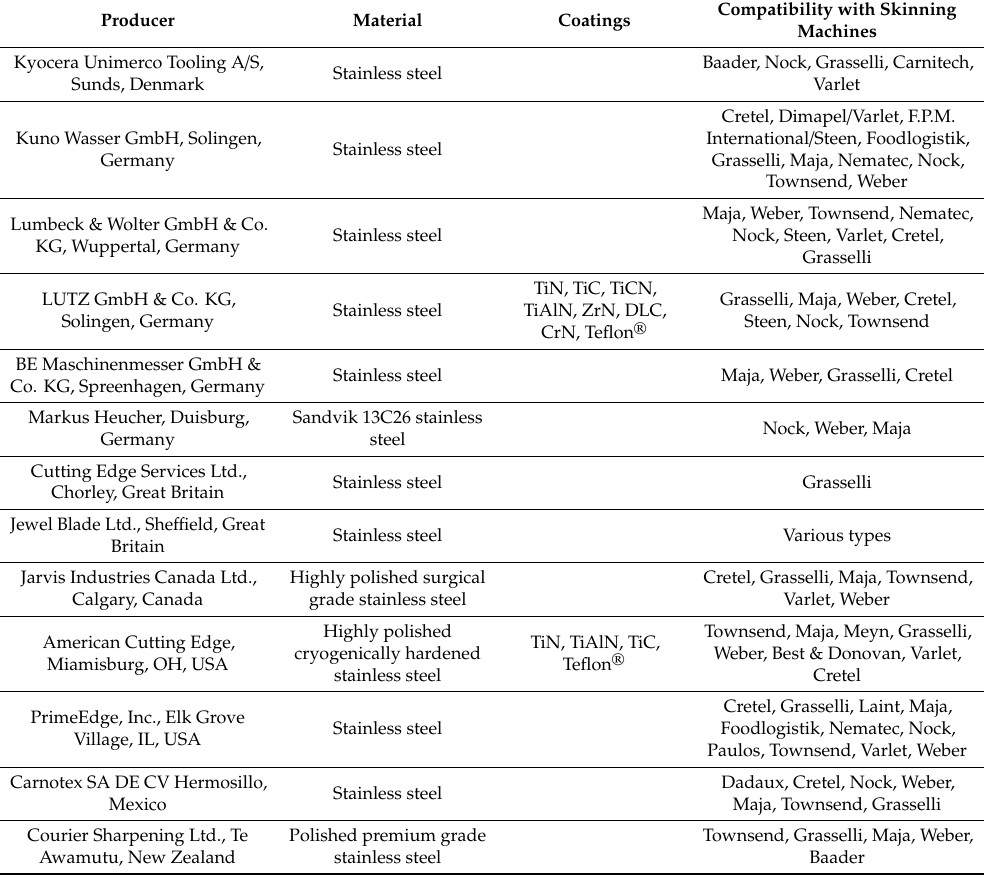
Table A1. Selected major manufacturers of industrial cutting blades for regular and deep